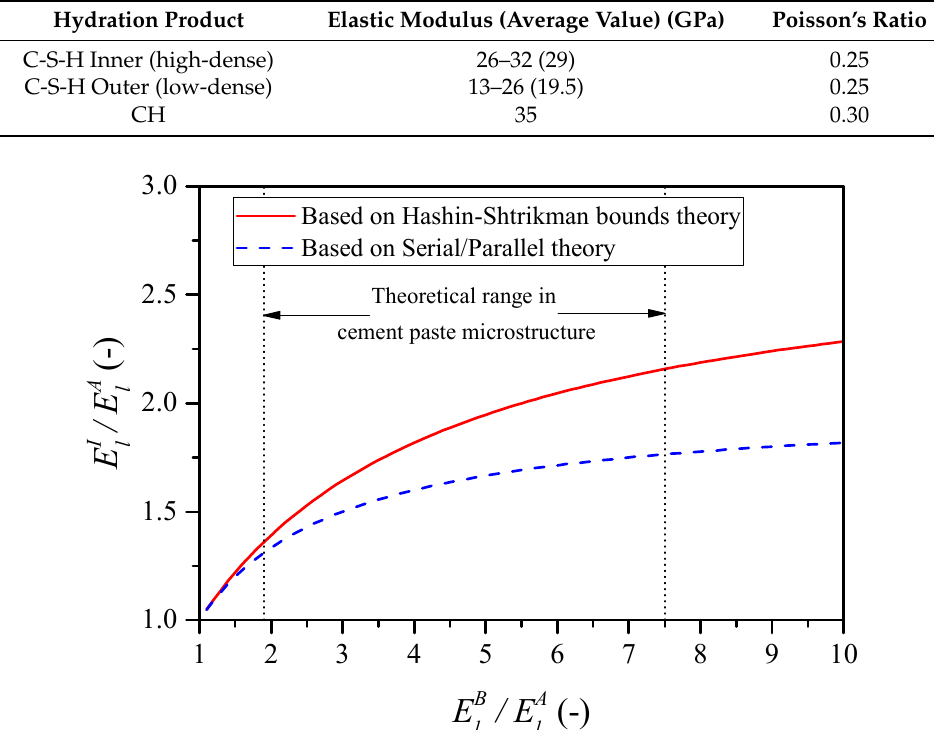
Figure 7. Effective Young’s modulus of an interface element calculated with two different methods: